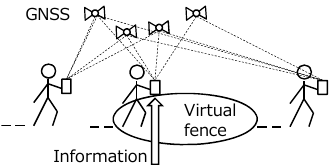
Figure 1. Geofencing using